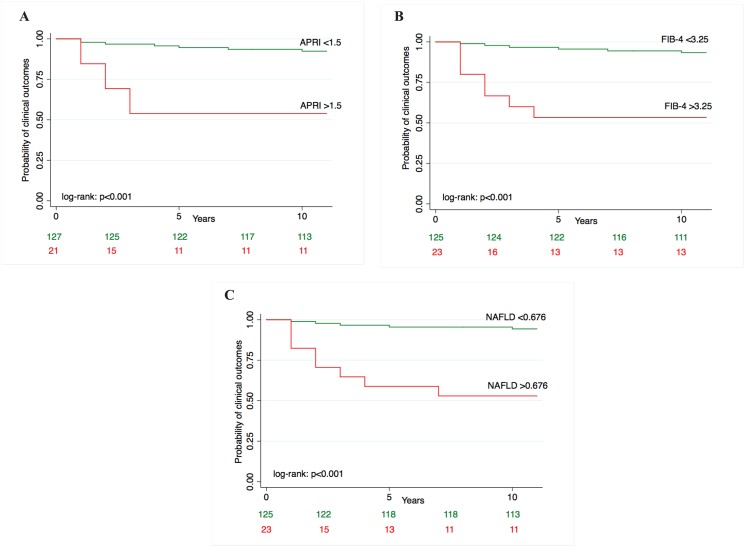
Survival curves of probability of clinical outcomes by: (A) APRI fibrosis category; (B) FIB-4 fibrosis category; (C) NAFLD fibrosis score category.